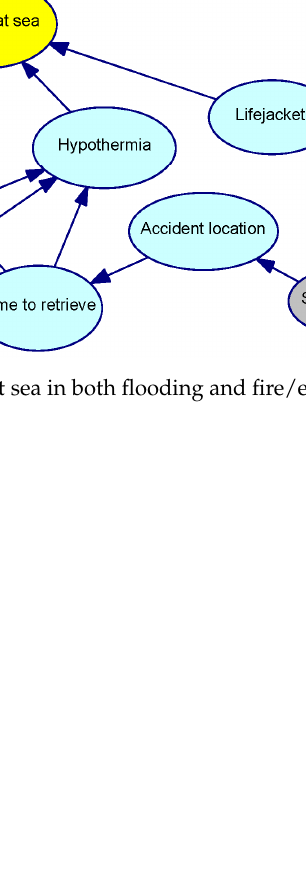
26 of 30 Figure A7. A Bayesian network for lifeboat clearing in flooding accidents (06).